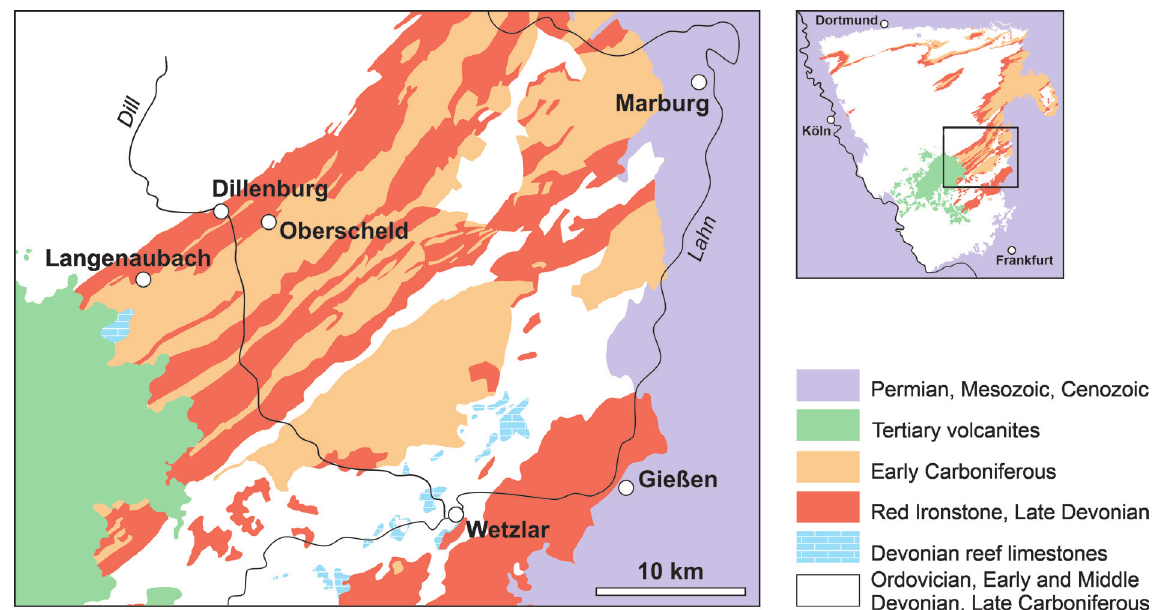
Fig. 1. The geographic position of the fossil locality of Oberscheld in the Rhenish